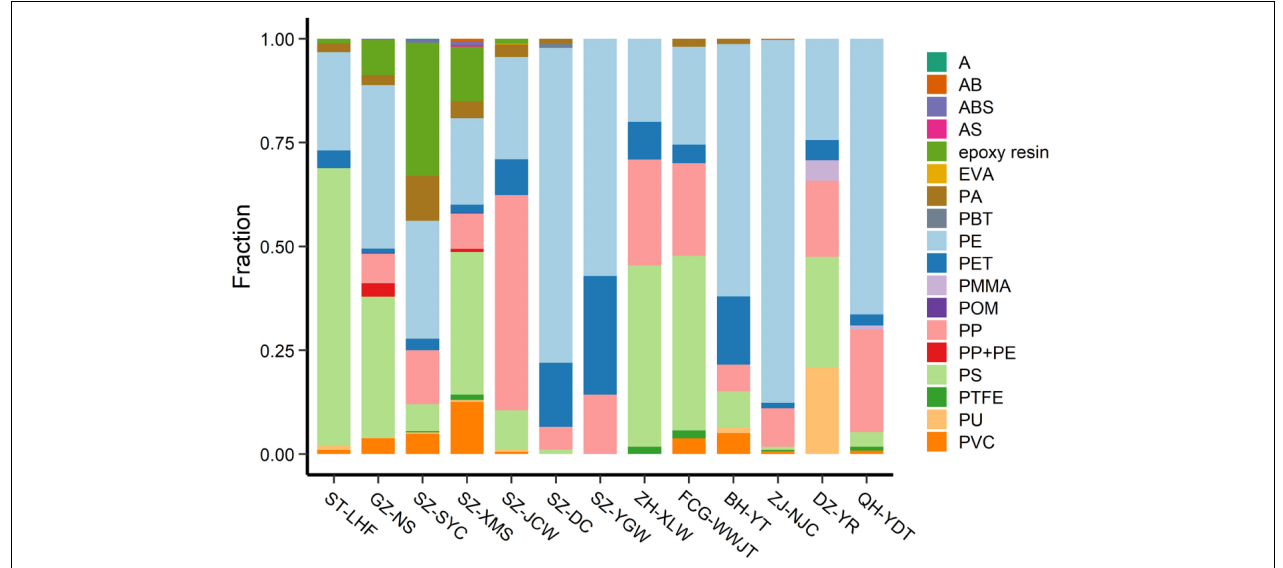
FIGURE 5 | Percentage of different MPs at each sampling site. Abbreviations for the MPs: PE, polyethylene; PS, polystyrene; PVC, polyvinyl chloride; PP, polypropylene; PP + PE, the mixture of PP + PE; PA, polyamide; ABS, the copolymer of acrylonitrile-butadiene-styrene; POM, polyoxymethylene; PET, polyethylene terephthalate; PU, polyurethane; AB, the copolymer of acrylonitrile-butadiene; PTFE, polytetrafluoroethylene; AS, the copolymer of acrylonitrile- styrene; A, acrylonitrile; EVA, ethylene-vinyl acetate; PBT, polybutylene terephthalate; PMMA, polymethyl